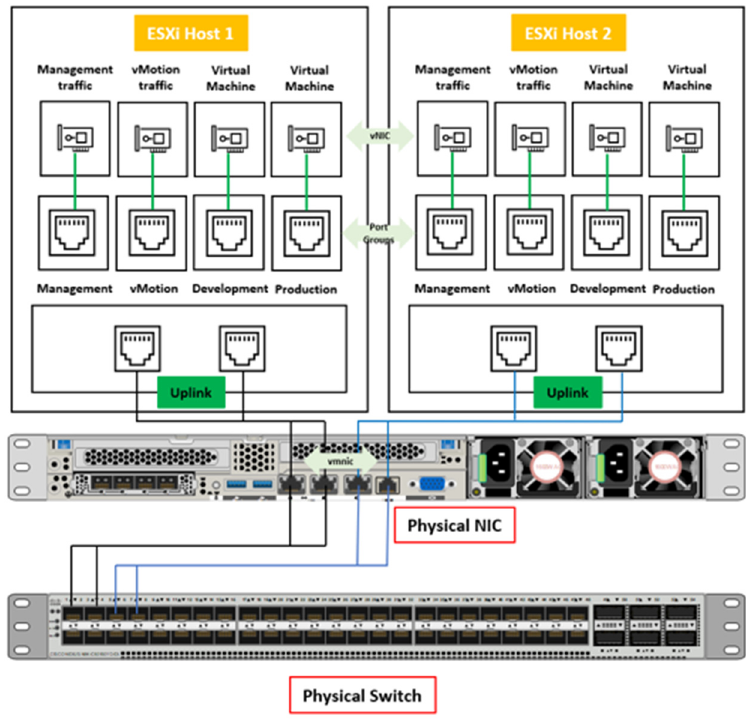
Figure 5. vSphere standard switch architecture [25].